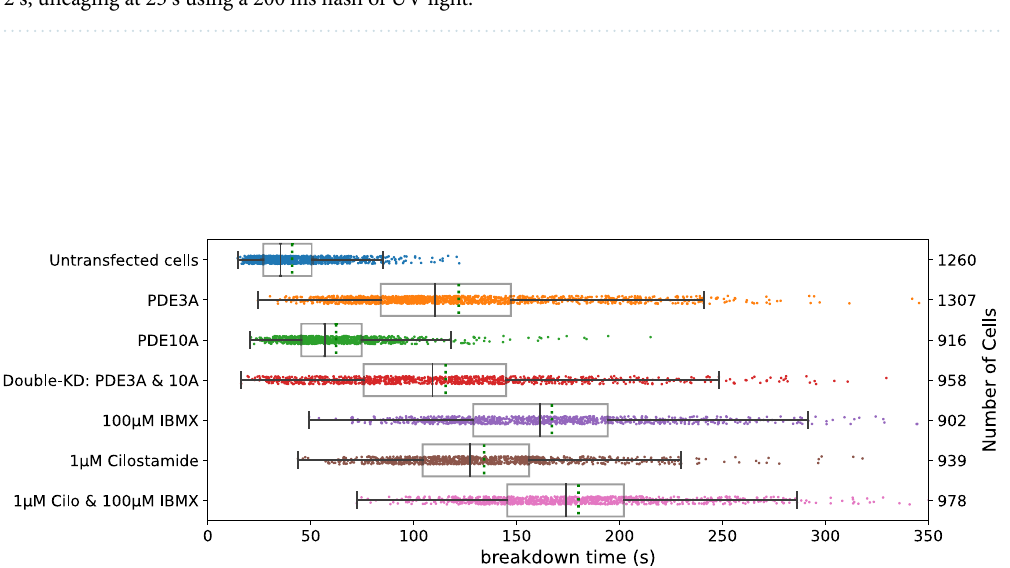
Figure 5. Breakdown of cellular cAMP after uncaging of DMNB-cAMP in HeLa cells. Datapoints represent the cAMP breakdown time values for all analyzed ROIs (individual cells) at a given condition. For each condition, the experiment was performed in duplicates, with cells grown, transfected, and assayed in two independent wells. Further details are as in Fig.